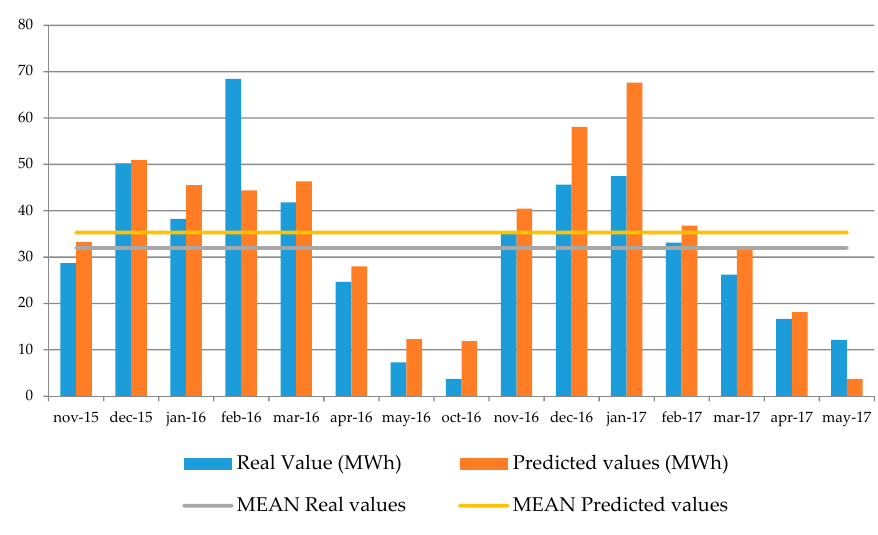
Figure 7. Mean real values and mean predicted values of consumption D3 building.